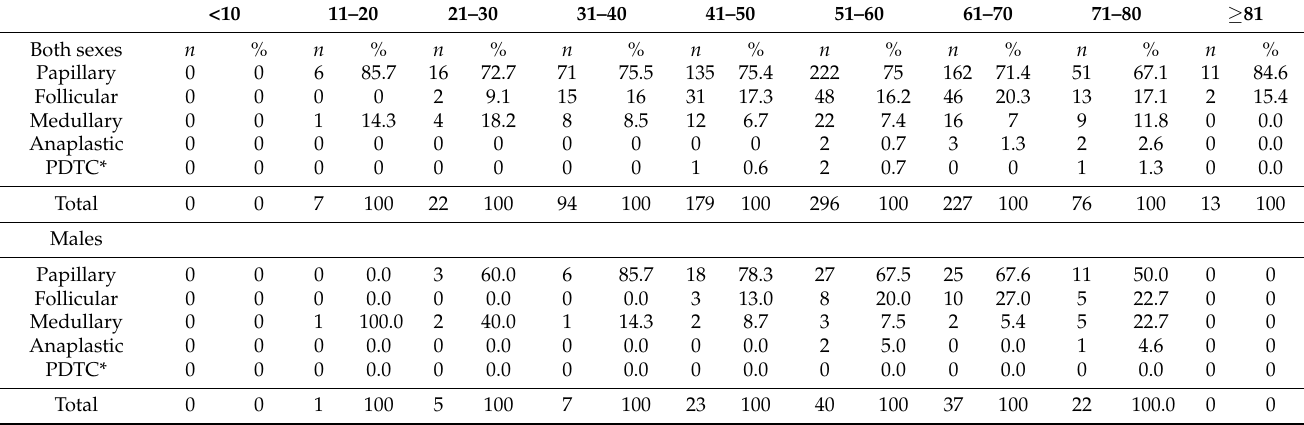
Table 3. Histopathological incidence by sex and age